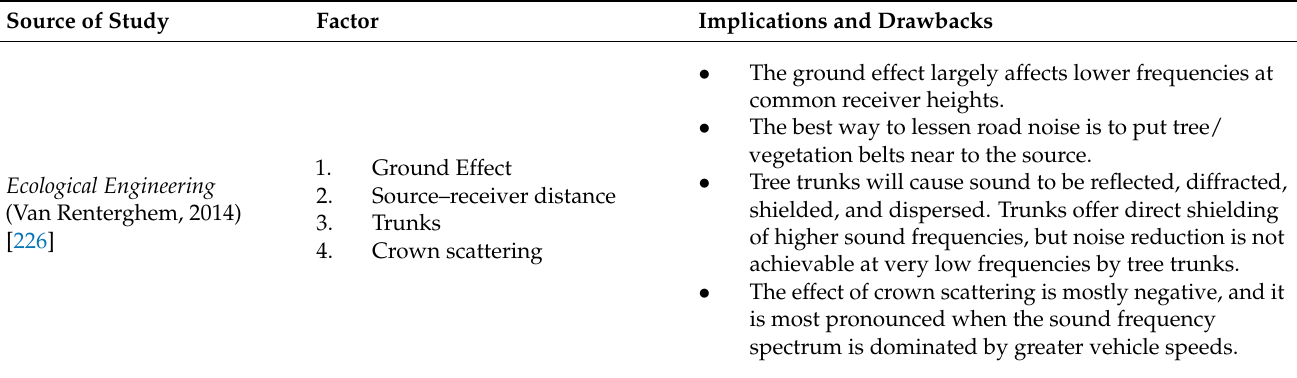
Table 1. The main factors on the FBG width and the locations of various